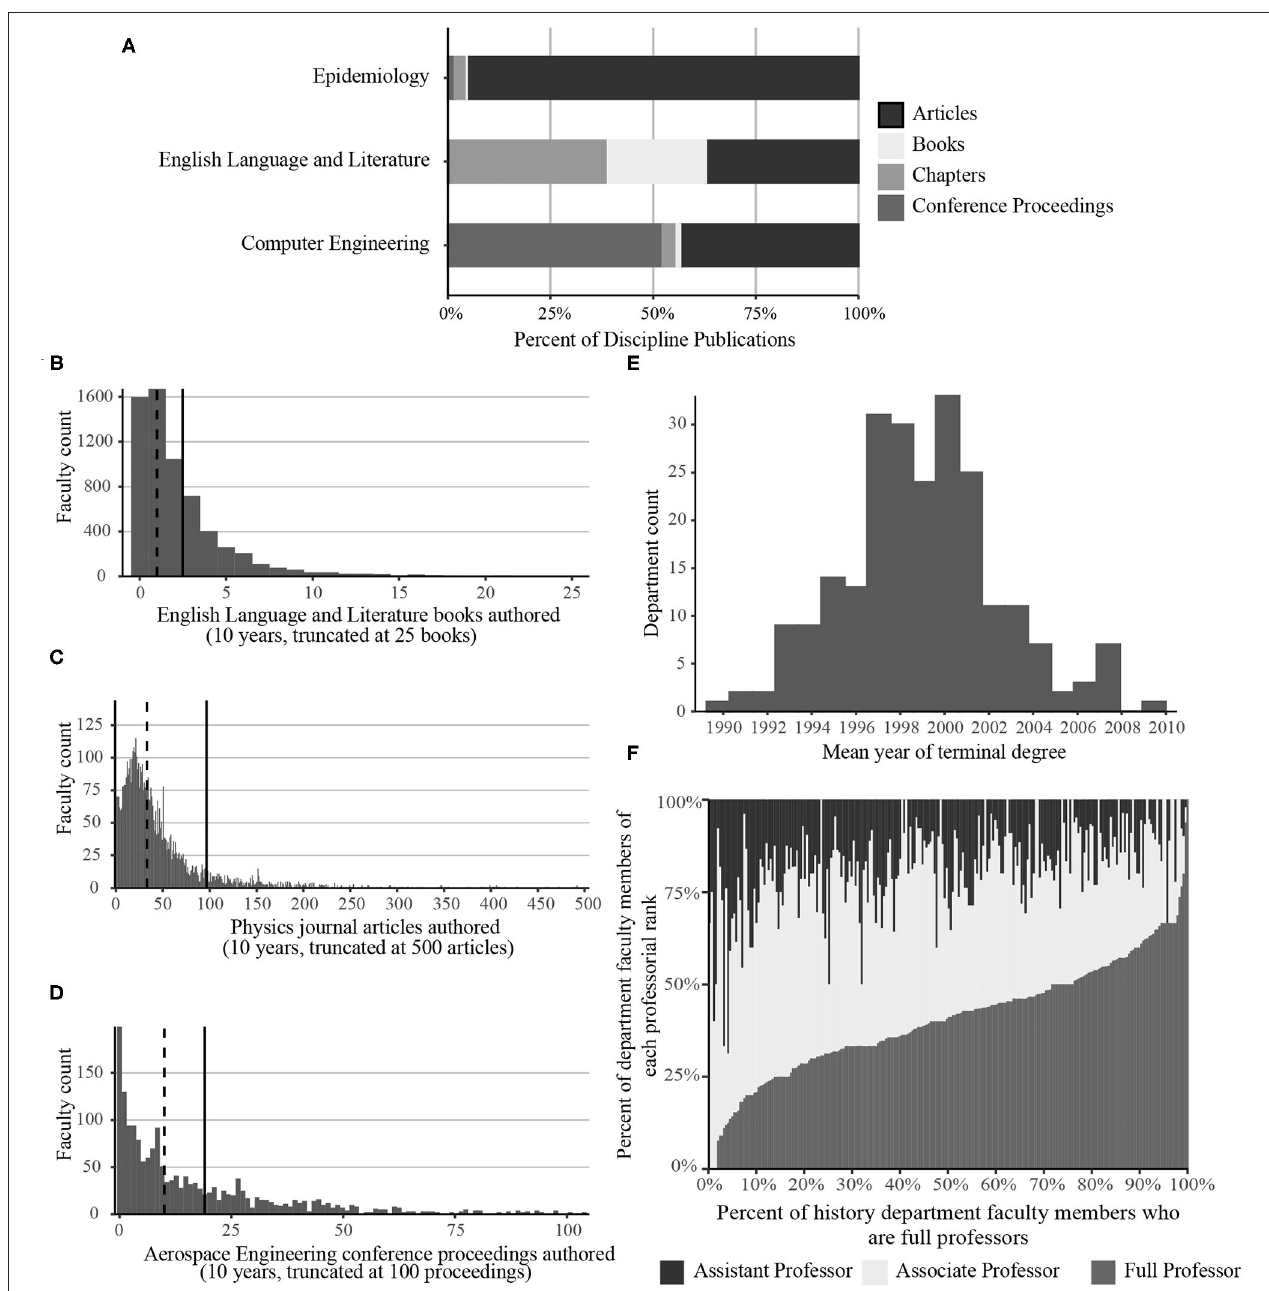
FIGURE 1 | (A) Percent of the total published literature represented by four research dissemination modalities (journal articles, books, chapters in edited volumes, and conference proceedings) in three academic disciplines with divergent publishing practices. (B–D) Publication count distribution (2010–2019) by number of faculty members for: (B) books authored by faculty members in departments of English Language and Literature; (C) journal articles authored by faculty members in departments of Physics, and (D) conference proceedings authored by faculty members in departments of Aerospace Engineering. In (B–D) , solid vertical lines represent the discipline mean and dashed vertical lines represent the discipline median. (E,F) Distributions of department mean year of terminal degree and department professorial ranks in History departments at US Ph.D. granting universities. In (E) , the mean year of terminal degree for each History department was calculated, and the departments were plotted as a histogram. In (F) , each History department is a vertical line showing the percent of faculty members in that department who are assistant, associate, and full professors; departments are sorted from left to right on increasing percent of full professors in the department. value in some disciplines (e.g., Figure 1C ). Schmoch